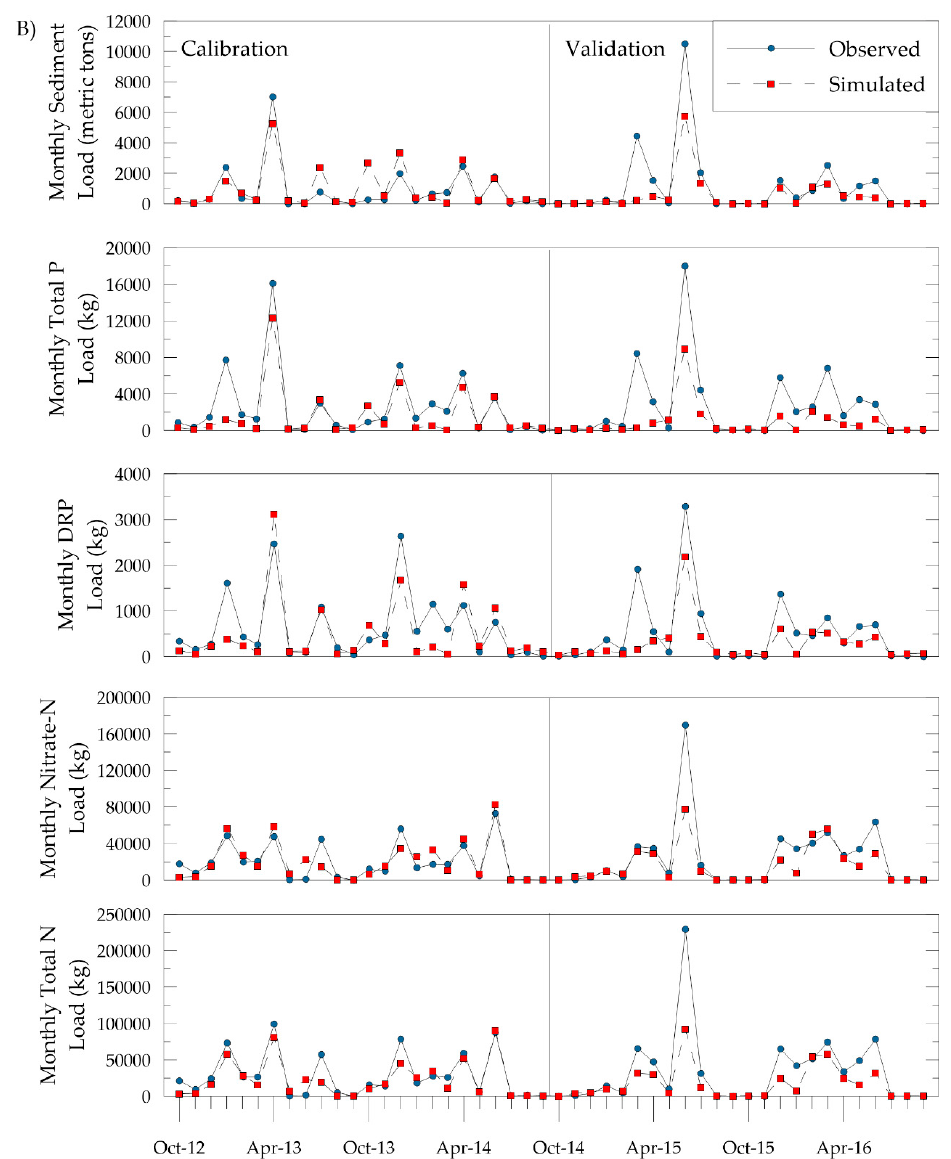
Figure 4. Comparison of monthly ( A ) observed precipitation and simulated and observed streamflow; ( B ) simulated and observed sediment, total phosphorus, dissolved reactive phosphorus (DRP), nitrate-nitrogen, and total nitrogen at the HUC12 outlet, Eagle Creek, Ohio.